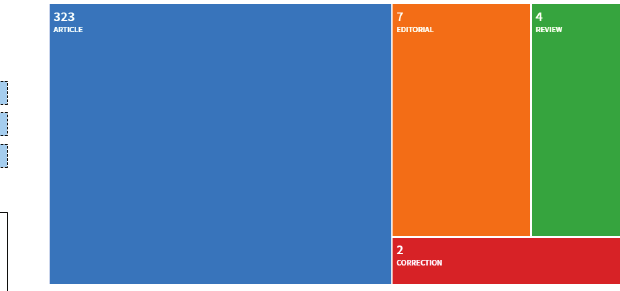
Figur e 2. Types of the IJSPM publications